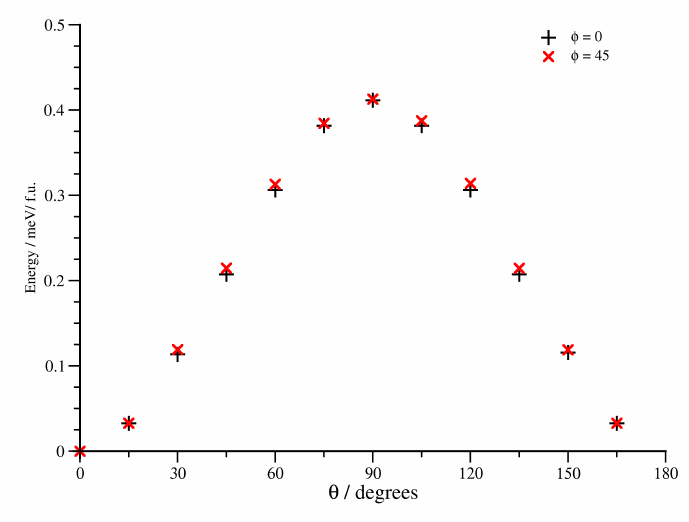
Figure 8. Variation of total energy (in meV) with angle from the easy axis, θ , for two values of the azimuthal angle, φ = 0 and φ = 45 ◦